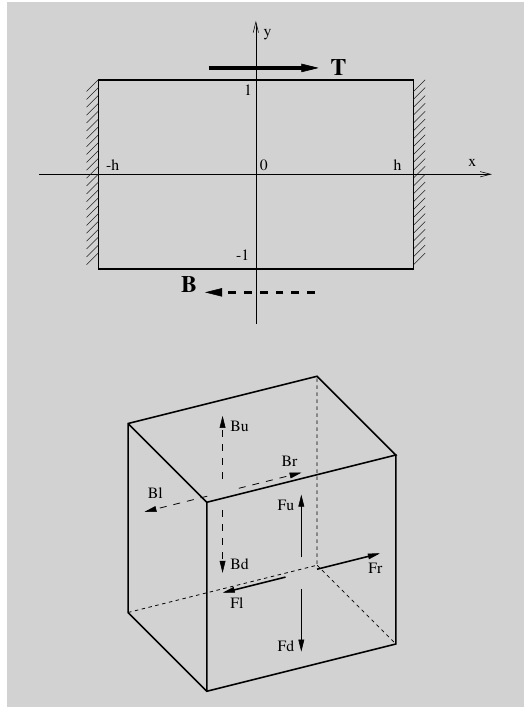
Figure 1: Geometries of the 2D and 3D cavity. In the upper figure during the first half of the period the top (back) wall is moved from left to right, and in the second half of the period the opposite (front) wall moved from left to right. This protocol is denoted as the TB protocol. The scheme of the flow domain for the cubic cavity and notation for possible motions of front and back walls is denoted in the lower figure; see text for explanation of the notation